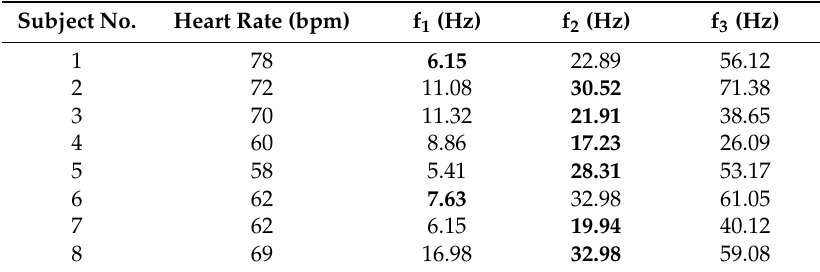
Table 5. Dominant frequencies of the actual SCG signals calculated using polynomial chirplet transform. The most dominant frequency for each subject is highlighted in bold.